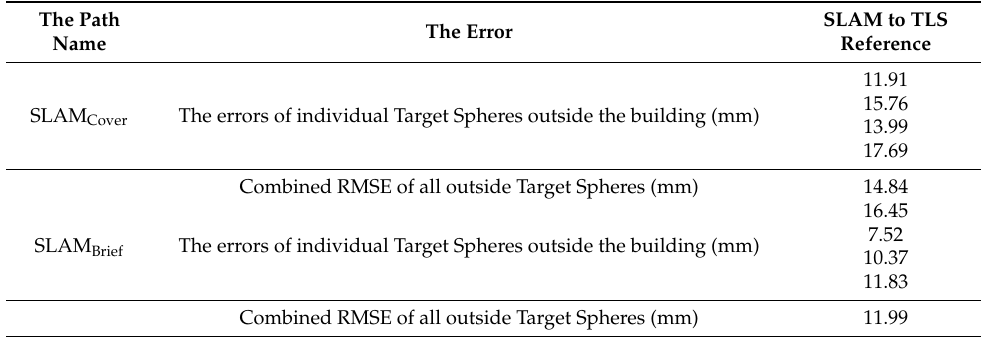
Table 4. The errors of Target Sphere of the SLAM LS alignment to the reference and the combined root mean square error (RMSE) of all Target Spheres. All four used Target Spheres were located outside, in front of the